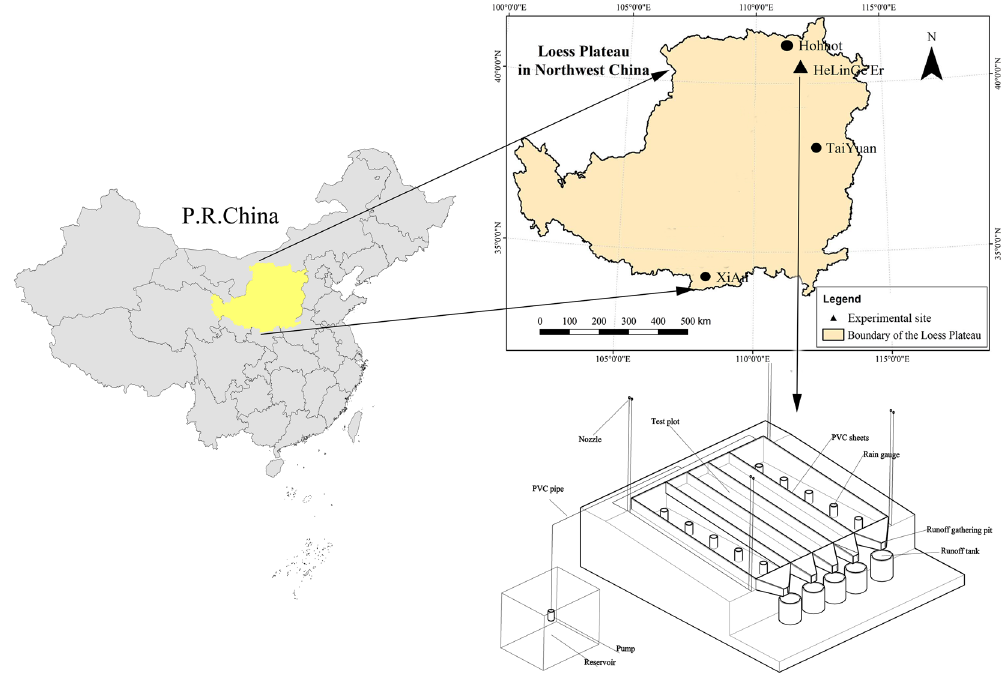
Figure 1. The experimental plot and simulation rainfall system. The map was generated using ArcMap 10.2.2